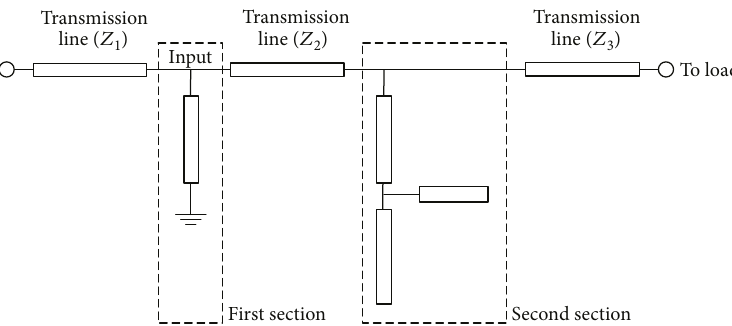
Figure 9: Con fi guration of the multisection dual-band matching network.